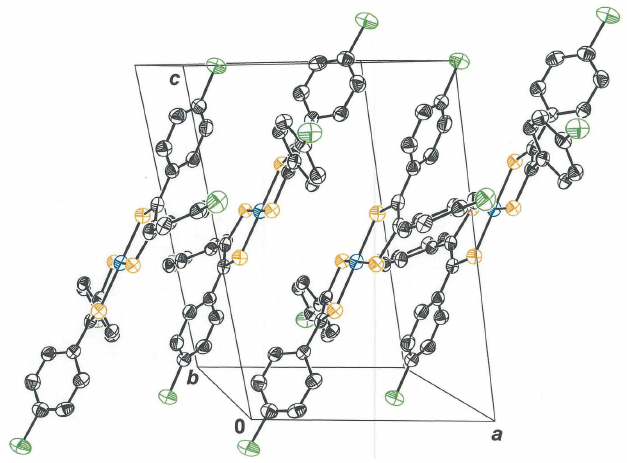
Figure 3 Packing arrangement of molecules of bis[1,2-bis(4-chlorophenyl)ethyl- ene-1,2-dithiolato(1 (cid:5) )]nickel(II) in the unit cell. Ellipsoids are shown at the 50% probability level, and all H atoms are omitted for clarity. Pairs of molecules are related by inversion across the center of symmetry at the center of the bc face.